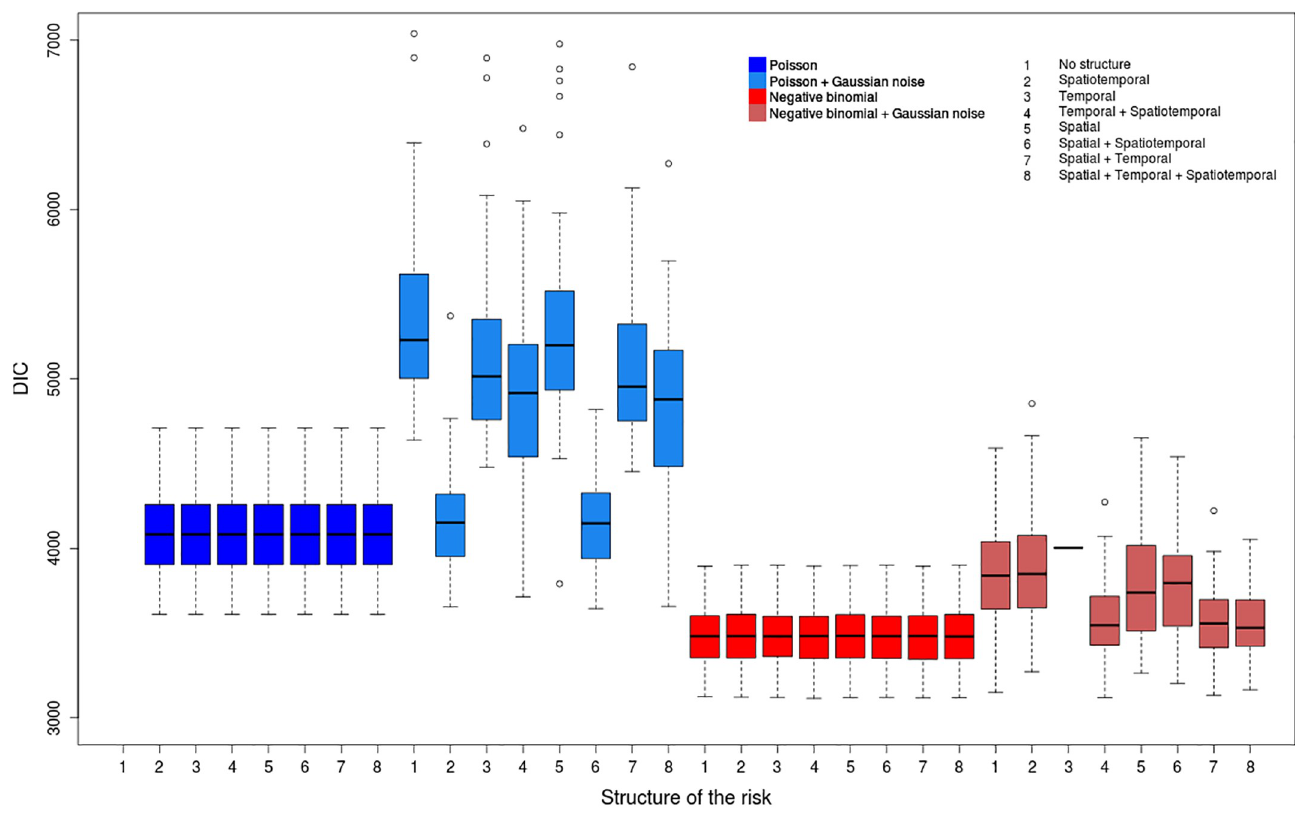
Fig 5. Distribution of DIC values for the scenario